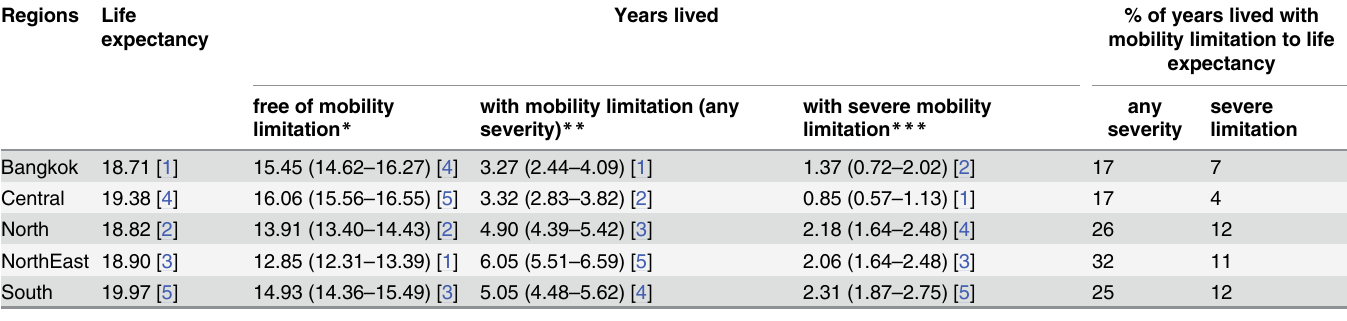
Table 4. Life expectancy, number of years lived in different states of mobility limitation (95%CI), and proportion of years lived with mobility limita- tion to life expectancy at age 60 for Thai males by regions, 2009. Regions Life expectancy